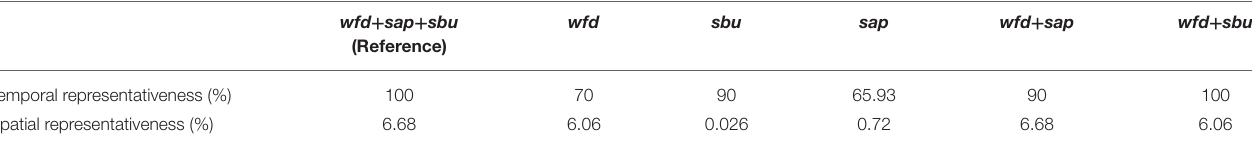
TABLE 3 | Temporal and spatial representativeness of the winter DIN reference dataset and all the aggregation